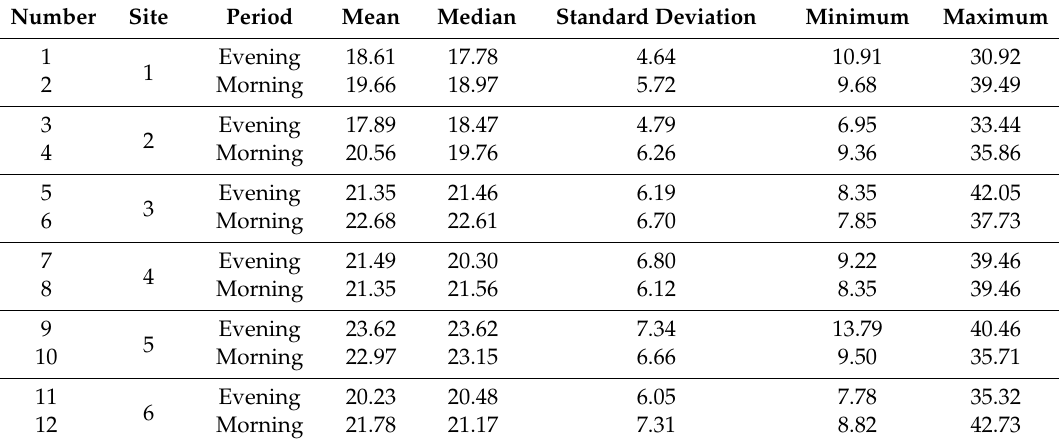
Table 3. Statistical Results for Bicycle Free Flow Speed (unit: km/h).